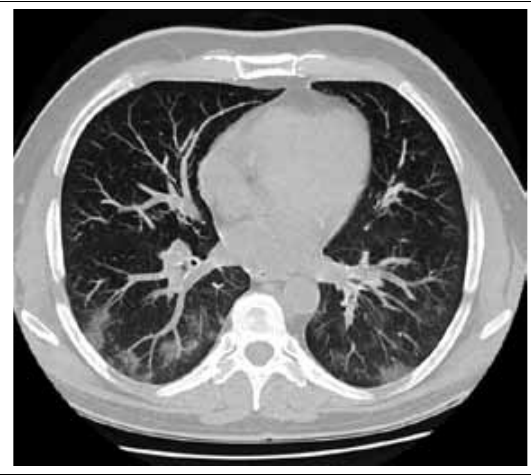
figurE 2 – Computed tomography through lung bases show zones of consolidation and areas of ground-glass attenuation